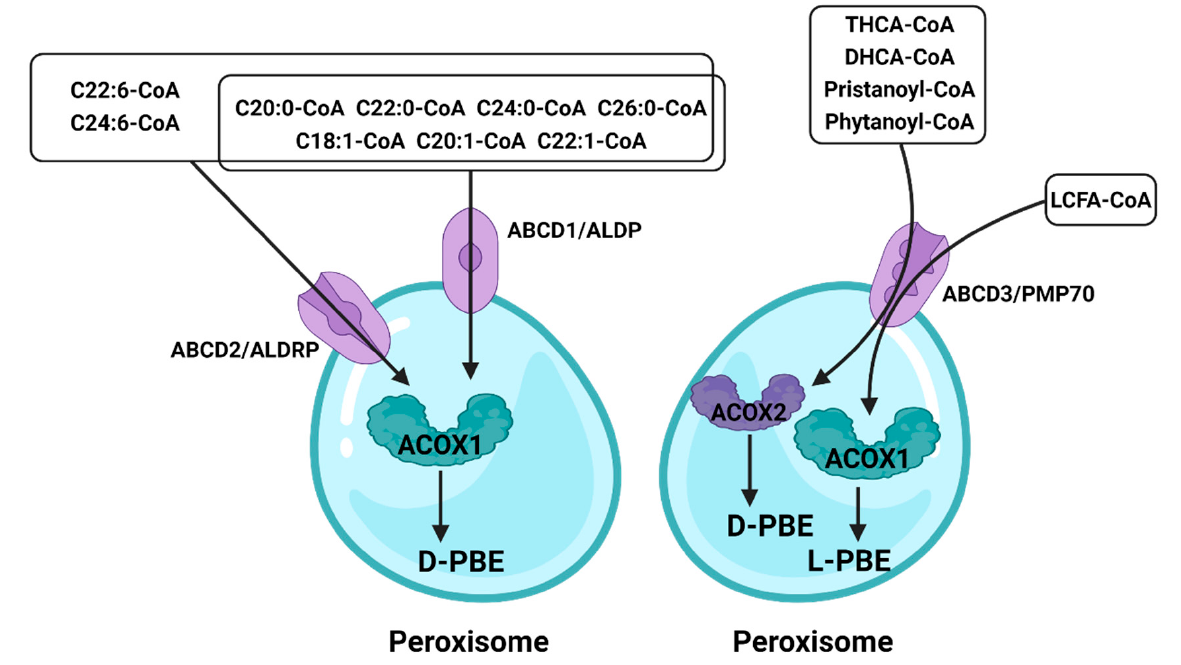
Figure 5. The role of the ATP-binding cassette in peroxisomal β -oxidation. Different fatty acids enter peroxisome through different ATP-binding cassettes, and ABCD2 has a broader role. Fatty acids that enter peroxisomes through ABCD3 are processed by different enzymes to achieve oxidation results.